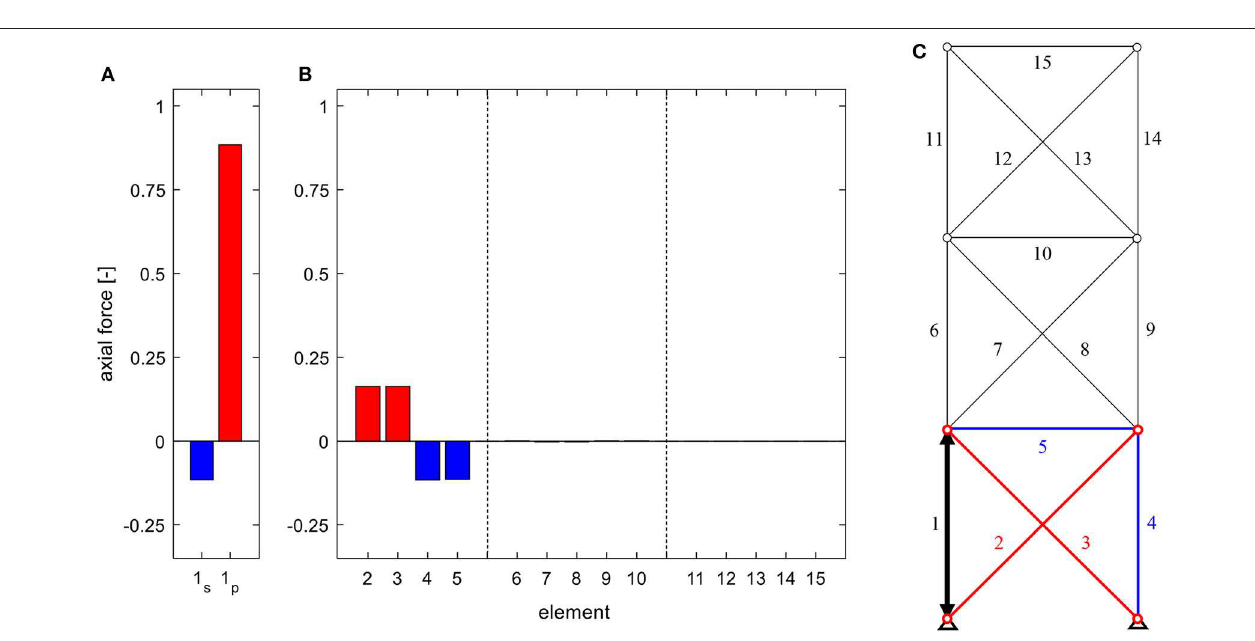
FIGURE 11 | Axial forces in (A) the actuated element for serial (index s ) and parallel (index p ) linear actuation, (B) the remaining structure due to the actuation of element 1 (C) , for a truss of the static degree of indeterminacy of n s = 3 and with modules of decreased stiffness bottom to top. this case, the influence of actuation of an element in of the influence, and to isolate the influence of actuation to the top module would still extend to the bottom module certain substructures. (equivalent to configuration in Figure 10 ). Careful placement of comparatively stiff elements or substructures in statically Lastly, two diagonal bracings of the lower two modules (one indeterminate systems can thus be used to control the area of each) are replaced by one overlapping bracing ( Figure 12 of influence of actuation forces, to create unilateral expansion